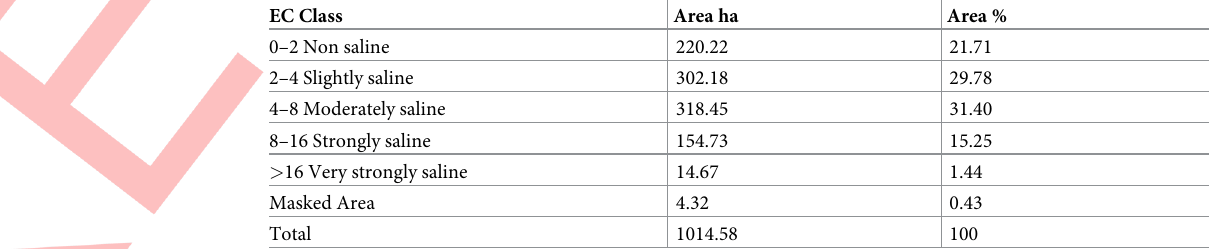
Table 9. Coverage area of different electrical conductivity (EC) classes in the study area estimated from the model